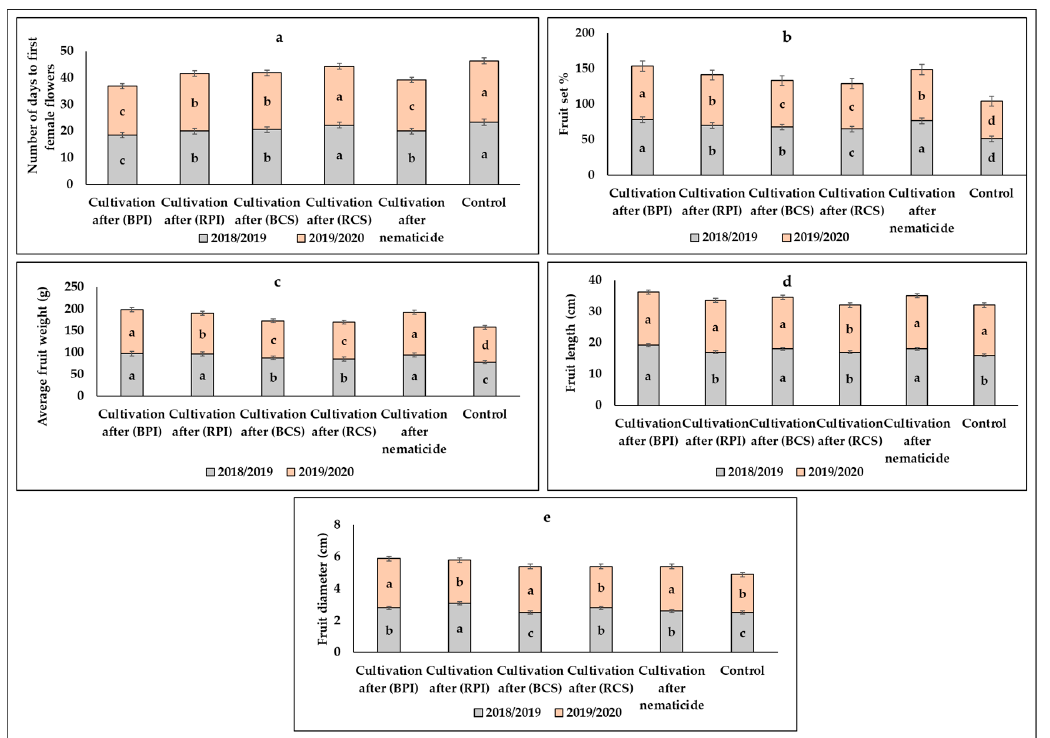
Figure 3. The effects of biofumigation, crop sequence, nematicide treatments compared with control on cucumber flowering and fruit characteristics, in two seasons 2018/2019 and 2019/2020. (( a ) Number of days to first female flower, ( b ) fruit set %, ( c ) average fruit weight (g), ( d ) fruit length (cm), and ( e ) fruit diameter (cm)). Means (±SE) followed by the same letter are not significantly different at p ≤ 0.05 (LSD test).